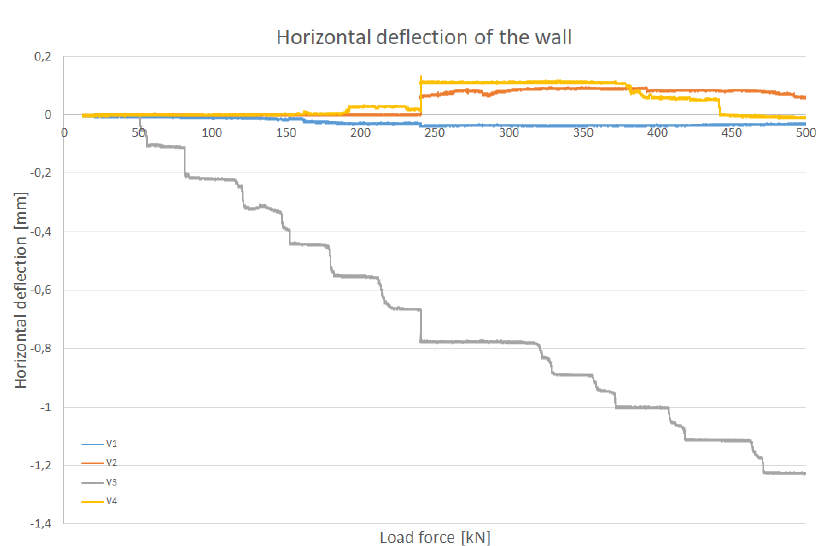
Figure 12. The load